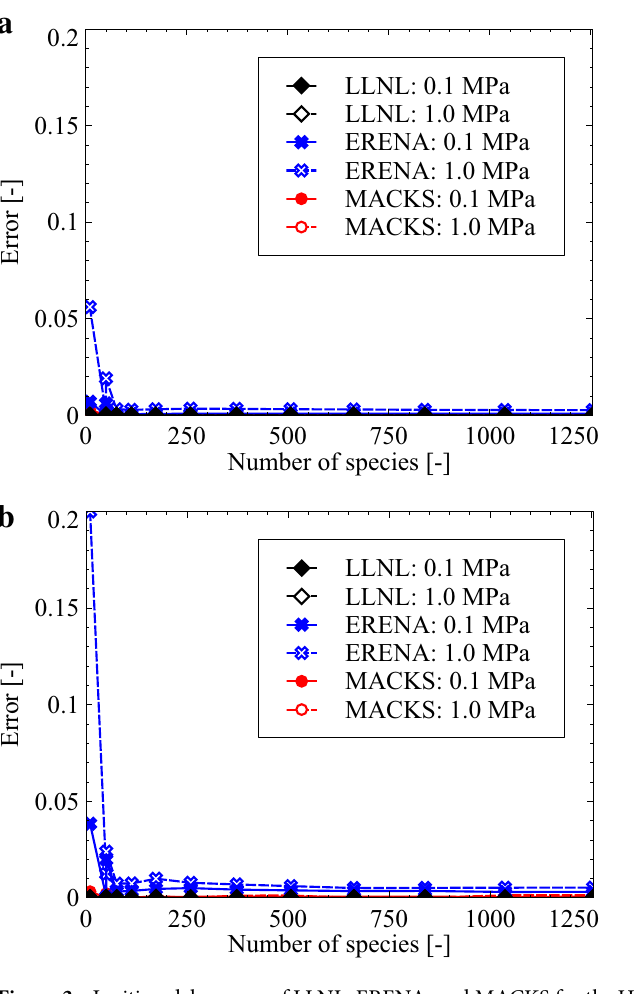
Figure 3. Ignition delay error of LLNL, ERENA, and MACKS for the H 2 /air and CH 4 /air— n - C 12 H 26 /air 8 7 mixtures where h = 1 × 10 − and 1 × 10 − , p 0 = 0.1 and 1 MPa, and T 0 = 1300K